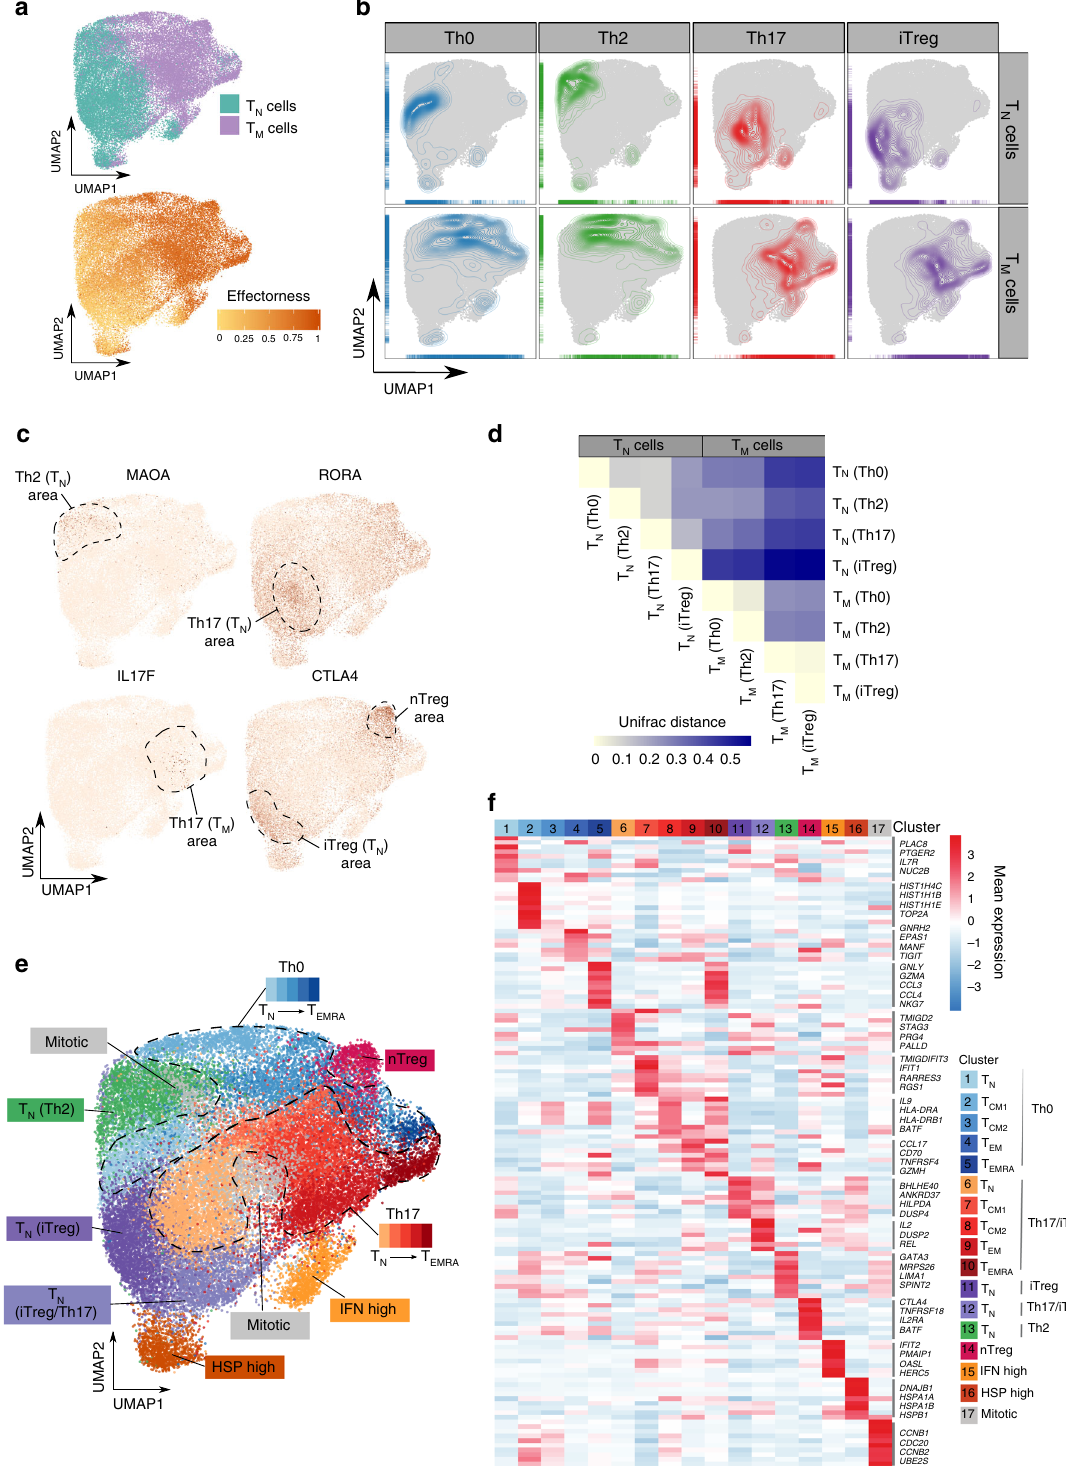
Fig. 5 The effectorness gradient persists after cytokine-induced T cell polarization. a UMAP embedding of stimulated T cells into a two-dimensional space. Cells are colored by cell type (top panel) or effectorness value (bottom panel). b Density plots highlighting cells based on the cytokine stimulations. c Expression of selected cytokine-speci fi c markers obtained from our bulk RNA-seq analysis. Cells are colored by their expression level of each marker gene. d UniFrac distances between T N and T M cells exposed to different cytokines summarized in a correlation plot. e Annotation of 17 cell clusters identi fi ed from unsupervised clustering using the top variable genes. Each cluster is annotated based on either the genes with highest expression or the effectorness and cytokine condition of the cells contained in it. b Heatmap of the top 10 markers of each cluster (Wilcoxon rank sum test). Colors encode the mean expression of each gene in each cluster. Labels were added to a number of example genes for each cluster. Source data are provided as a Source Data fi